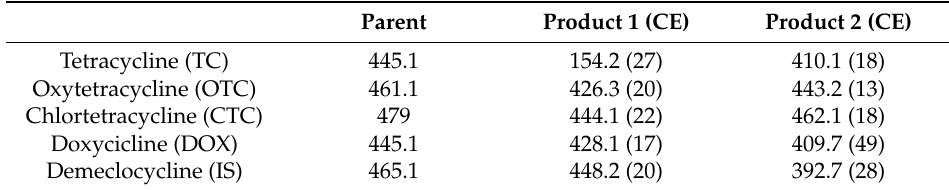
Precursor and most abundant product ions and their optimal collision energy. IS = internal